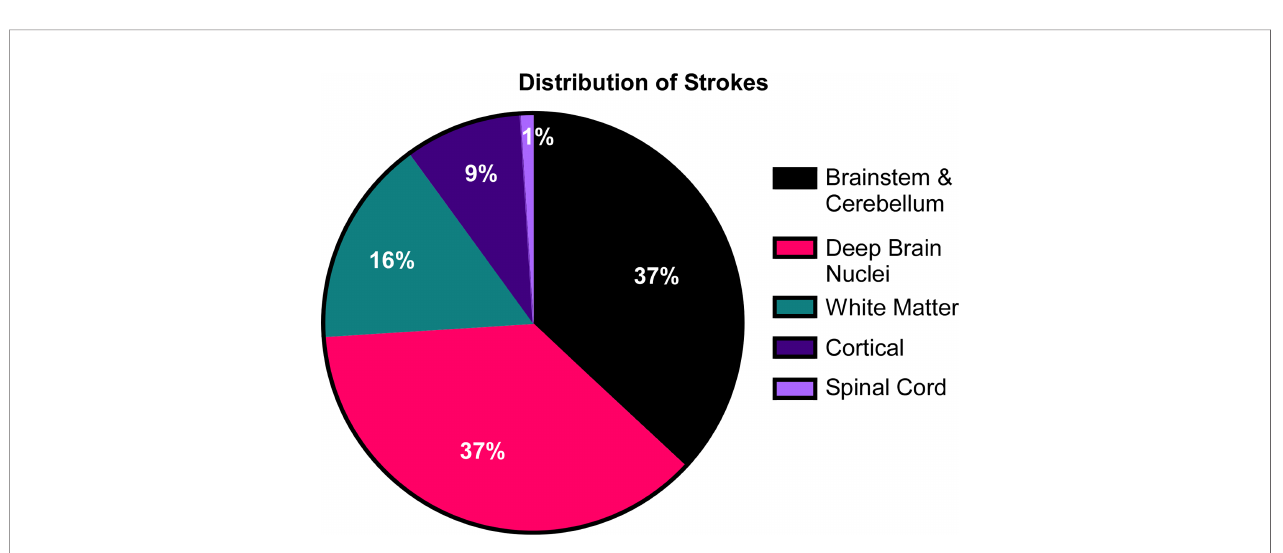
FIGURE 6 | The distribution of strokes in DADA2. In the cohort of 58 patients, 25 patients amassed a total of 76 lacunar strokes. Their distribution was focused primarily in the deep brain nuclei, brainstem and cerebellum.